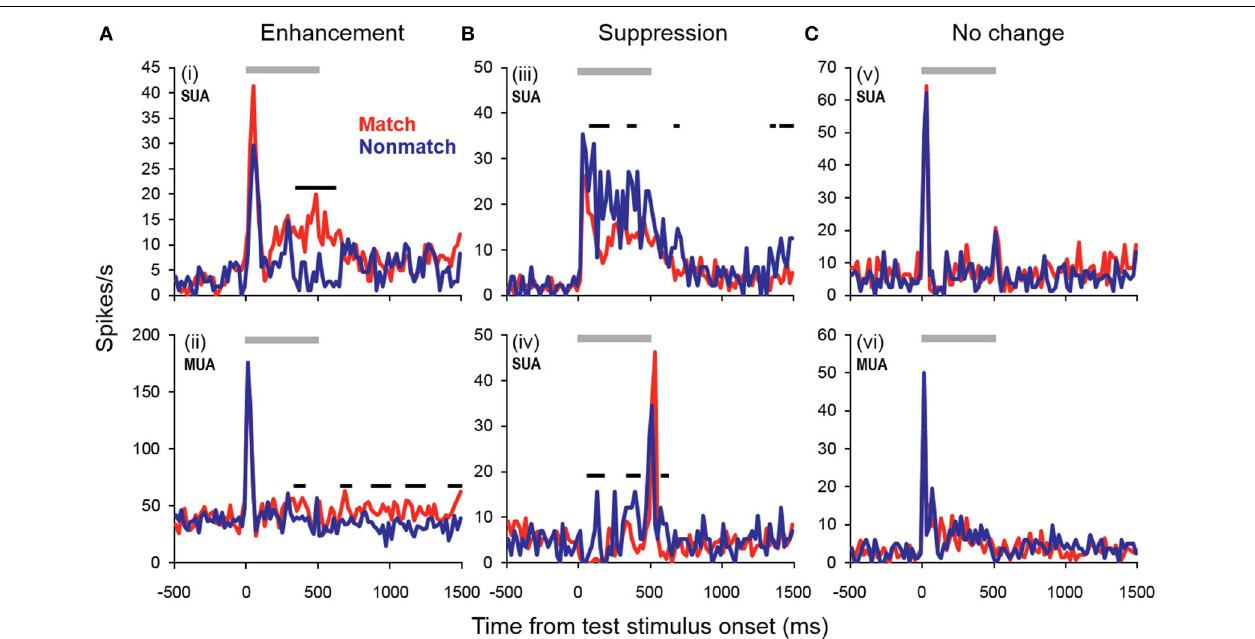
FIGURE 4 | Example units showing match enhancement, suppression, or no change. (A) Example units for which enhanced firing rates were elicited by matching compared to non-match test sounds. (B) Example units for which suppressed firing rates were elicited by matching compared to non-match test sounds. (C) Examples of units for which there were no significant differences in firing rate elicited by matching and non-matching test stimuli at any point during the cue, offset, or pre-response wait periods.